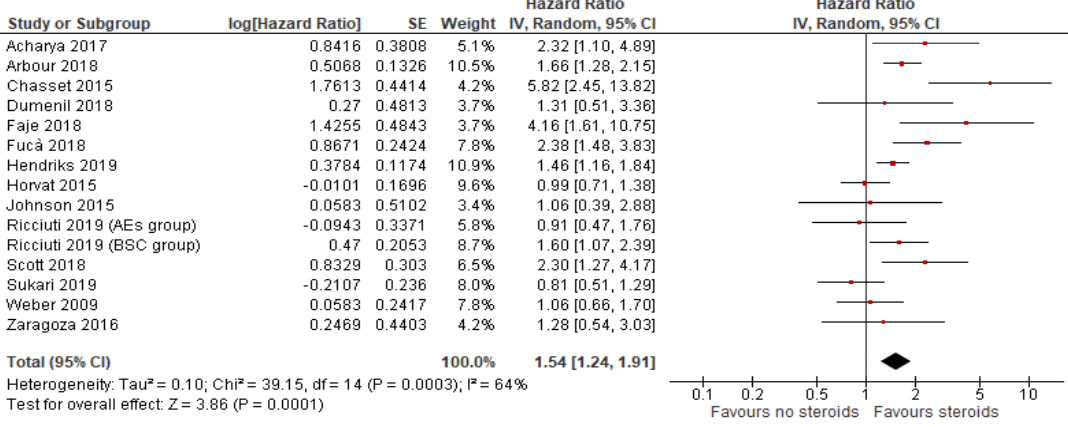
Figure 2. Overall survival comparing use or not of steroids concomitant to immune checkpoint in patients with cancer.